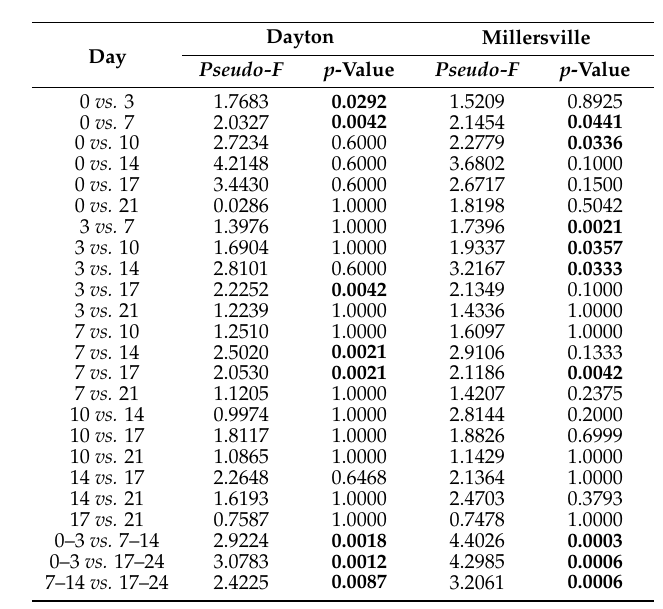
Table 3. Differences in communities based on day of decomposition were determined using post-hoc comparisons with Bonferroni corrections. Days were further binned into three timeframe categories based on visual patterns to further comparisons in Figure